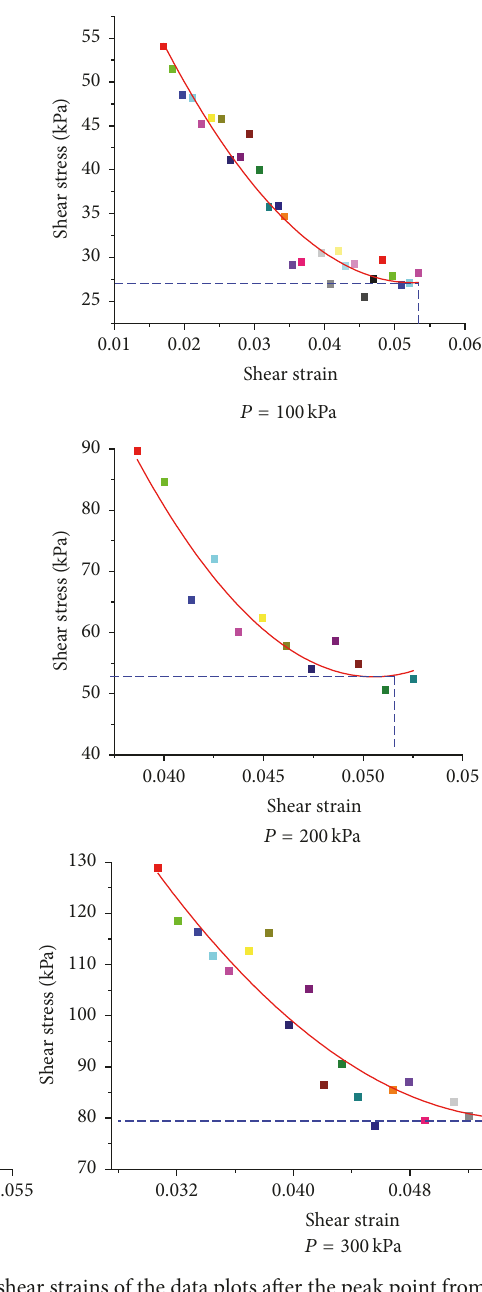
Figure 15: Functional relations between the shear stresses and shear strains of the data plots after the peak point from binomial